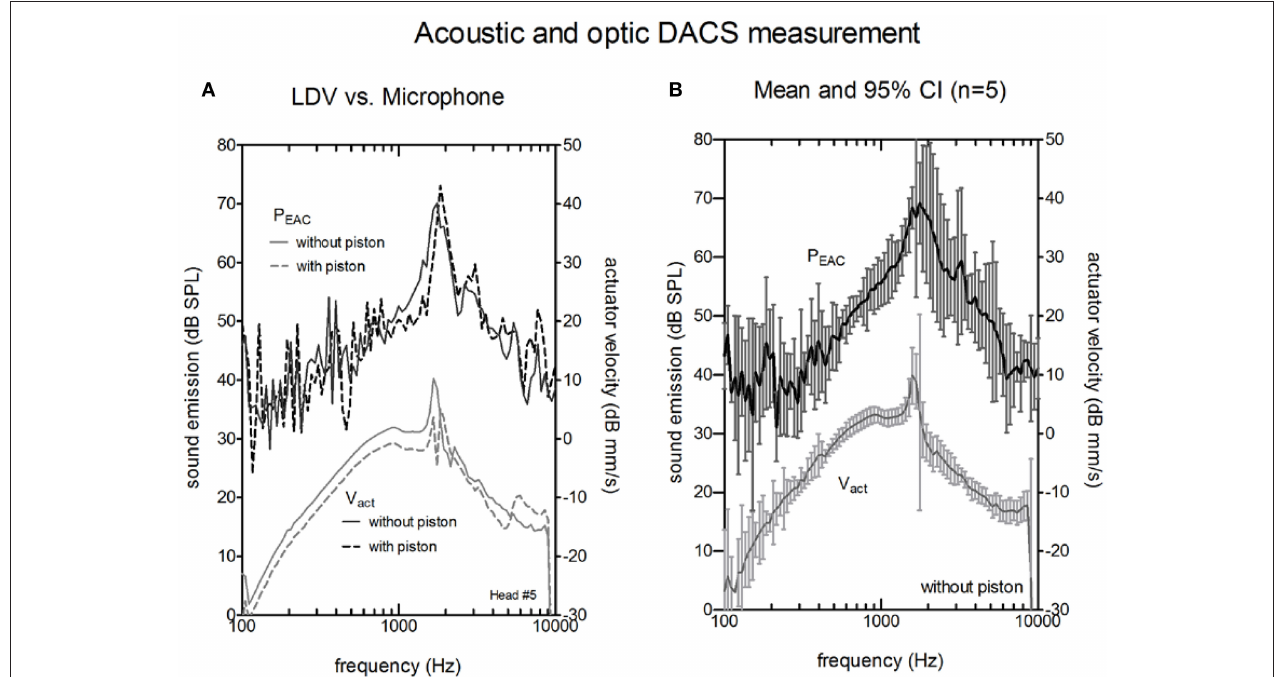
FIGURE 4 | Actuator velocity of the vibrating rod V act (lower curves, right y-axis) and the resulting sound pressure in the ear canal P EAC (upper curves, left y-axis). (A) A single measurement without piston (solid lines) and with piston (dashed lines) actuators using a Laser Doppler Vibrometer (LDV). (B) Average magnitude of P EAC and V act of the five actuators without a piston. The bars indicate the confidence interval (CI).